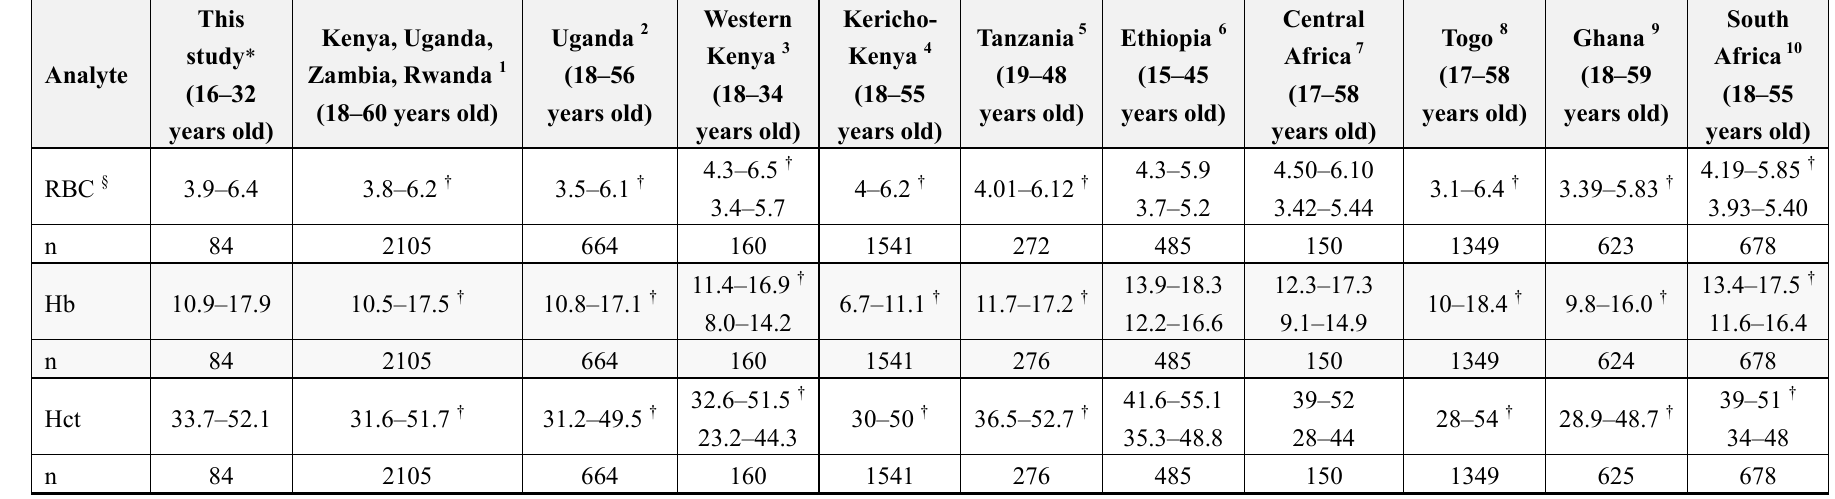
Table 4. Comparison of hematology ranges with other studies in Africa: 16–32